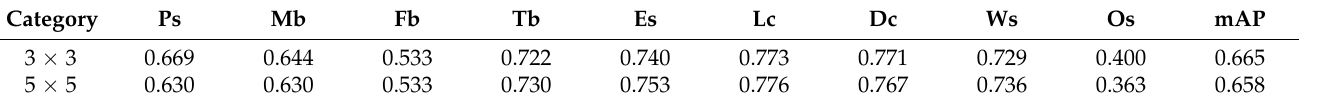
Table 6. AP values of various targets detected using different deformation convolution sizes.